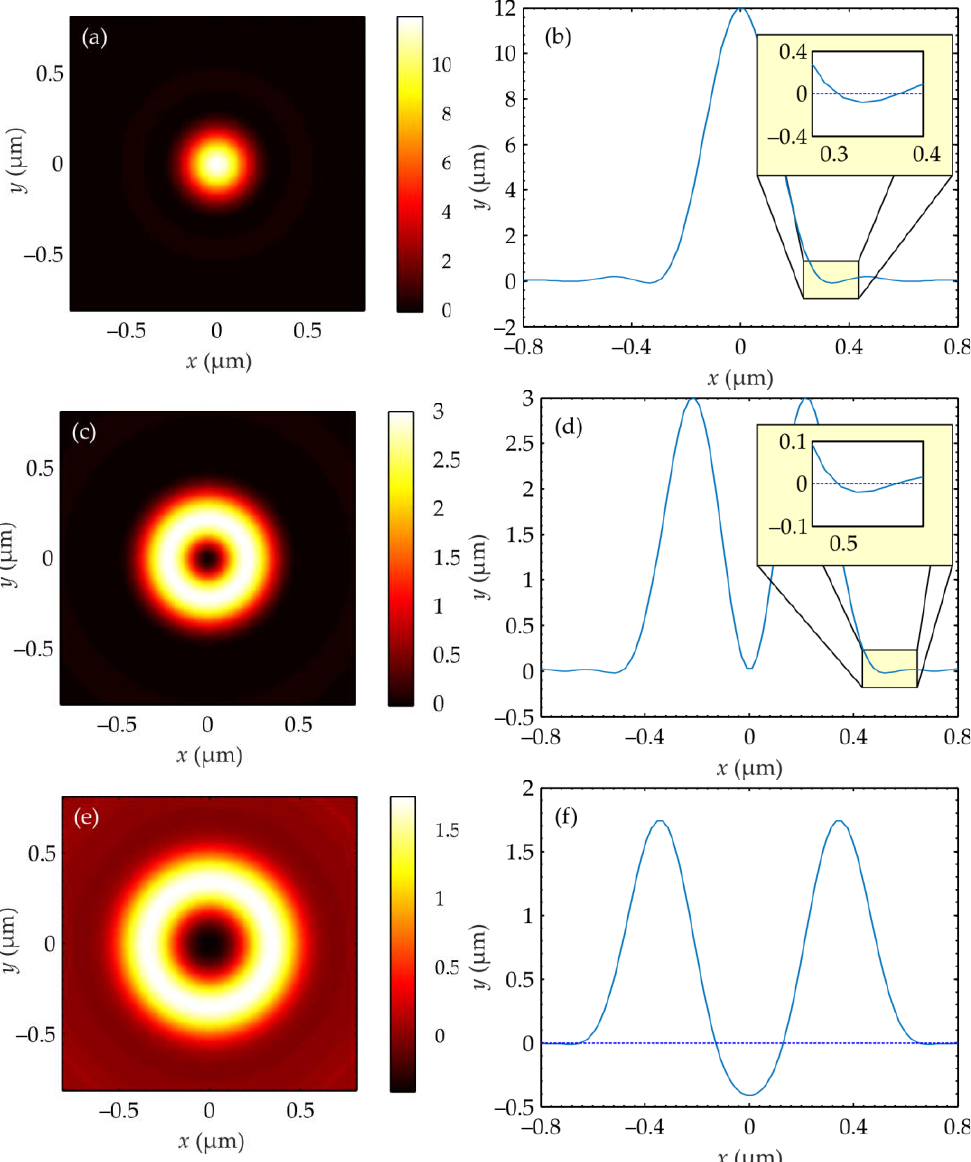
Figure 3. Distributions of the axial projection of the SAM ( S z ) and their cross-sections along the x -axis